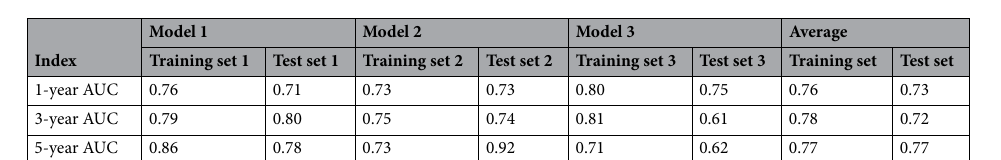
Figure 2. The expression changes of eRRGs between STAD samples and corresponding normal samples. ( A ) The differentially up-regulated eRRGs (red nodes) and down-regulated eRRGs (blue nodes) are shown in volcano plot. ( B ) The expression profiles of top 20 up-regulated eRRGs (red) and top 20 down-regulated eRRGs (blue) is shown in heatmap. The grouping information is shown in the top bar and the color represents the value of log 2 FPKM (fragments per kilobase of transcript per million mapped reads). The bubble plots show the functional enrichment analyses of up-regulated eRRGs ( C ) and down-regulated eRRGs ( D ). The size of bubble reflects the overlapped gene numbers between each GO term and query gene set. ( E ) The left plot shows the important module having the highest MCODE score and corresponding functional enrichment results. The right plot represents the top 10 remarkable nodes ranked by MCC and corresponding functional enrichment results. The color of nodes denotes the value of log 2 FC.